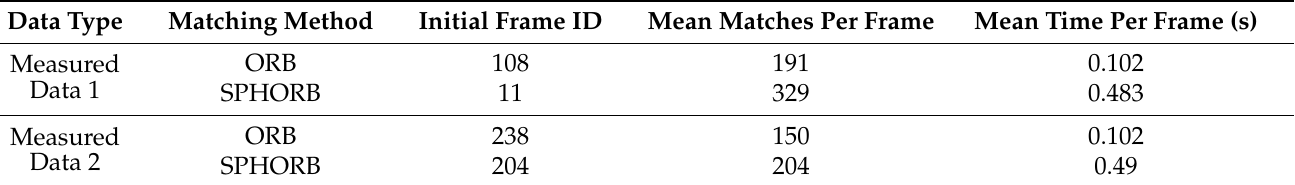
Table 3. Comprehensive evaluation of ORB and SPHORB.